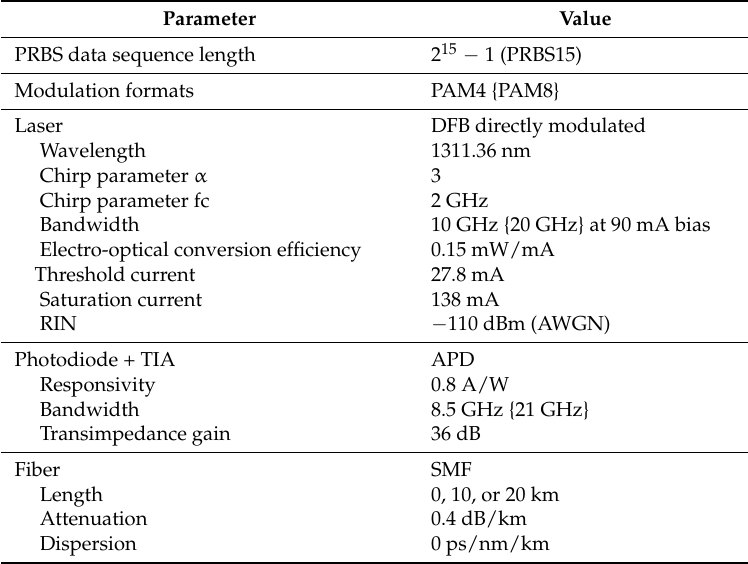
Table 1. Transceiver and transmission parameters.